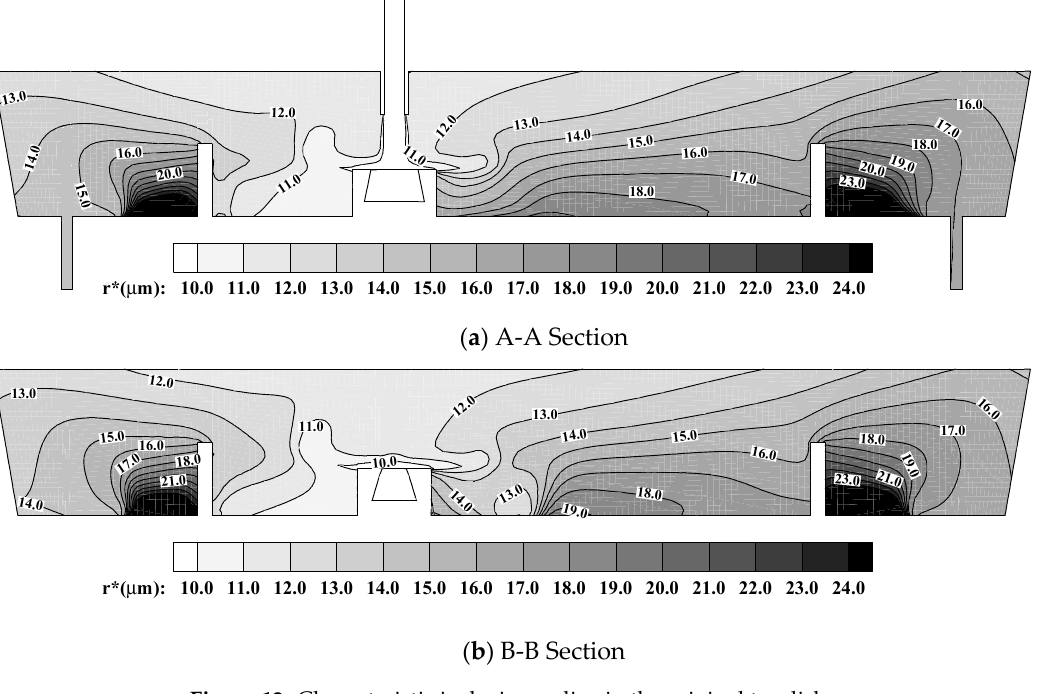
Figure 12. Characteristic inclusion radius in the original tundish.